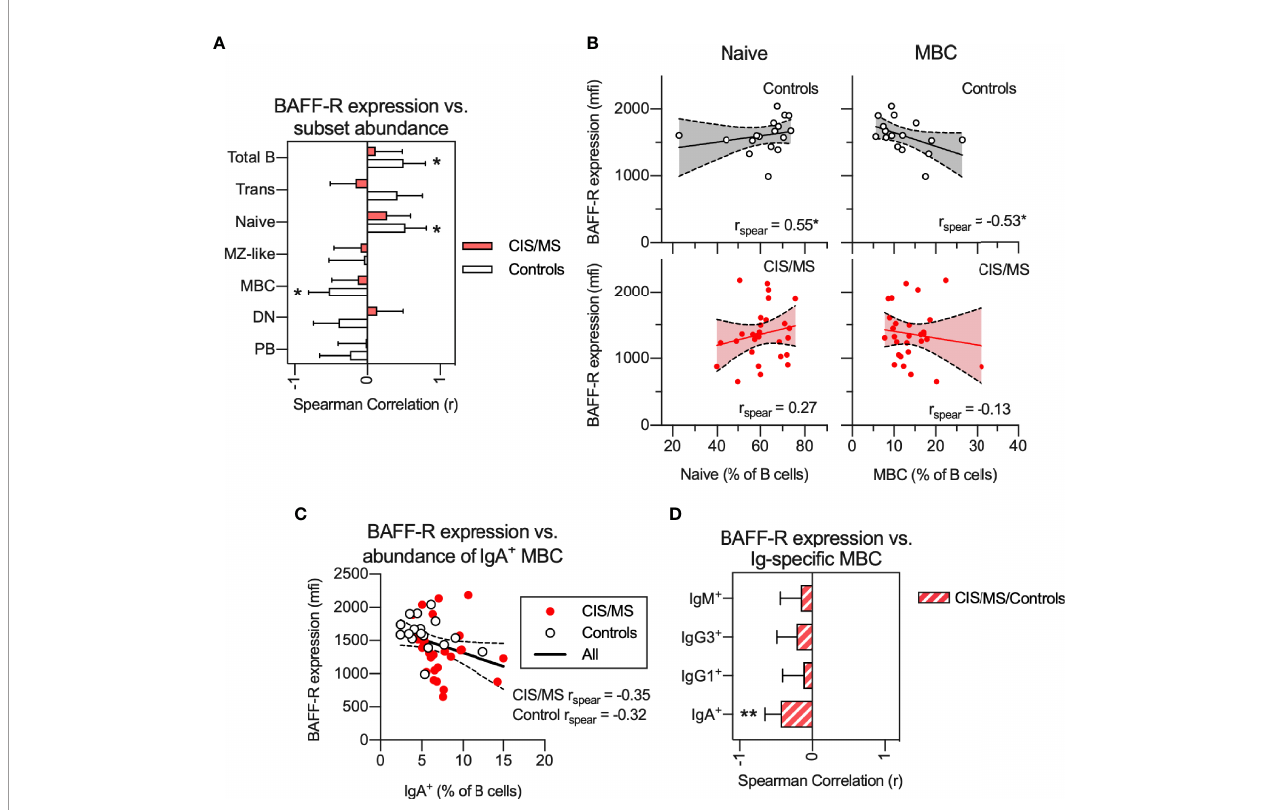
FIGURE 5 | (A, B) Non-parametric correlation between BAFF-R expression on BAFF-R + B cells and abundance of B cell subsets in CIS/MS patients and controls (A) as well as display of raw data for correlations with abundance of Naive and MBCs in CIS/MS and controls (B) . (C) Correlation of BAFF-R expression on BAFF-R + B cells and abundance of IgA + MBC. (D) Non-parametric correlation between BAFF-R expression on BAFF-R + B cells and abundance of isotype speci fi c MBC in the combined group of CIS/MS patients and controls. Data are displayed as mean correlation ± 95% CI (A, D) or for each participant (n CIS/MS = 28, n Controls = 17) in (B, C) . Correlations are visualized using a linear fi t and 95% CI. Signi fi cance of correlation was calculated using Spearman non-parametric test displayed as p<0.01, **; p<0.05,